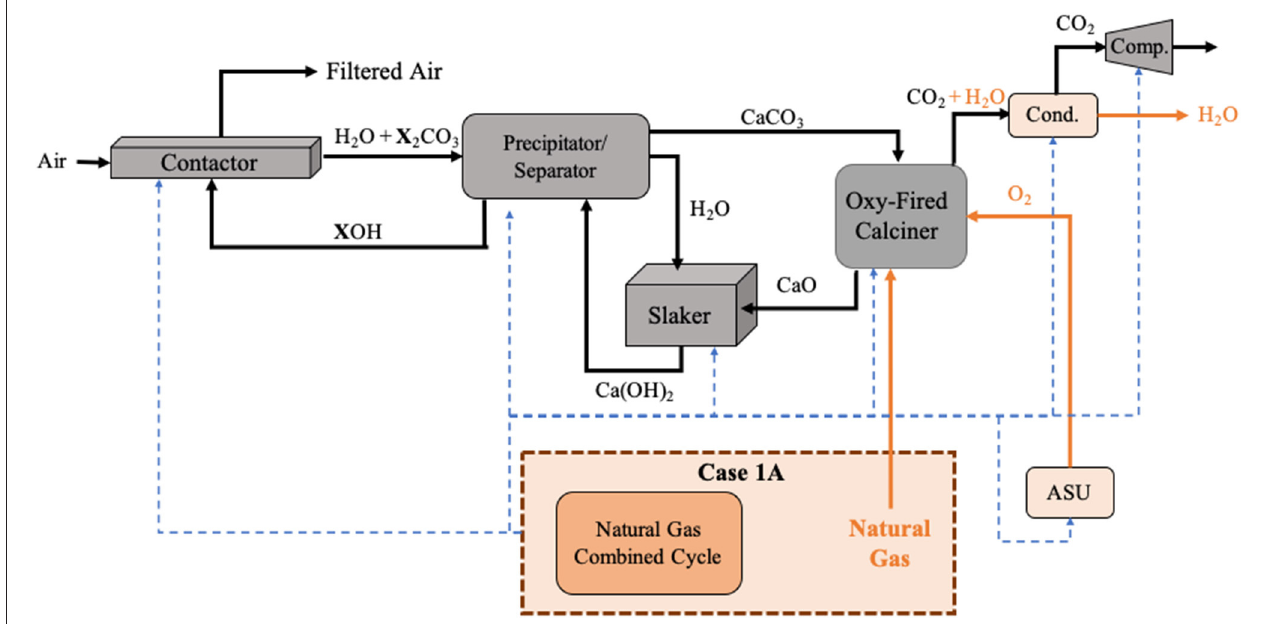
FIGURE 2 | Schematic of DAC Case 1A where natural gas is internally combusted in the oxy-fired calciner, providing the thermal energy, and a natural gas combined cycle provides the electricity requirements for the system. The dashed blue arrows represent the flow of electricity within the system. The orange boxes and flows represent unit operations and species that are unique to Case 1A. X represented sodium (Na) or potassium (K) depending on the hydroxide used.